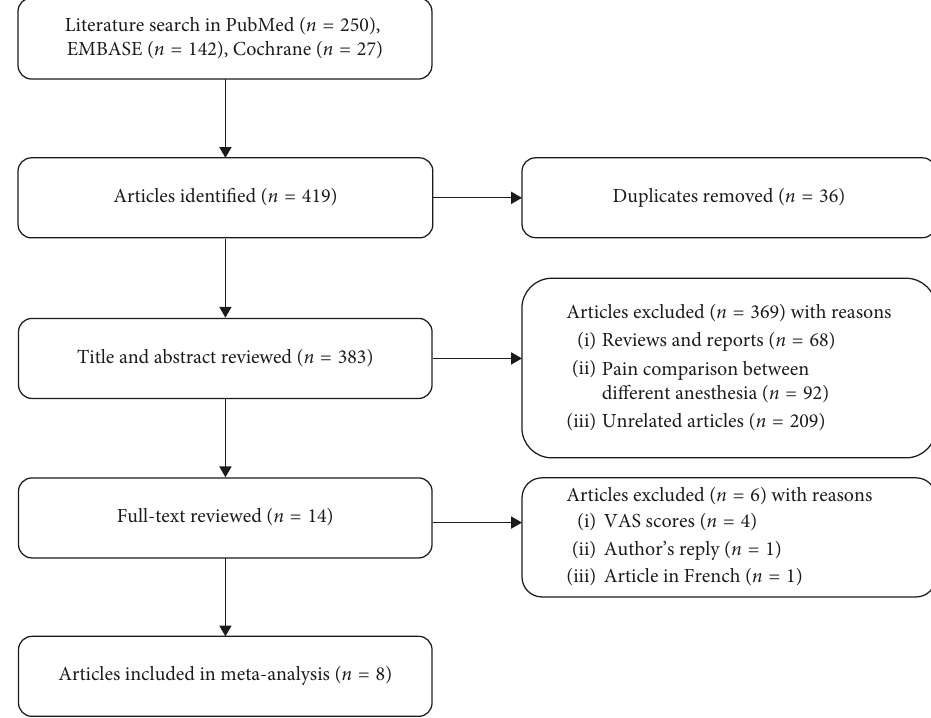
Figure 1: Study selection